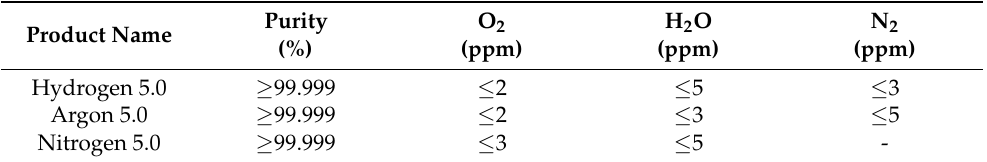
Table 6. Purity and residuals of the process